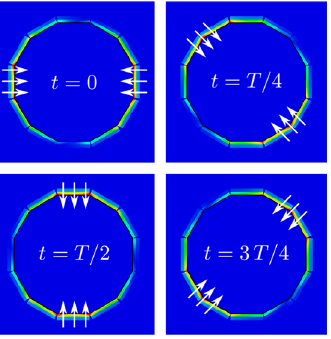
Figure 6. Simulated current distribution of the antenna array at different time phases, where T is the period, for the first mode (i.e., ℓ = + 1 ) at 28 GHz. Series of radiating copper edges tangential to the top plane of the circular antenna array, which are rotating versus time, leads to radiation in z -direction over the tangential to the horizontal plane E φ electric component, which, in turn, leads to formation of OAM modes along z -axis: this operation mechanism is well-described in 25